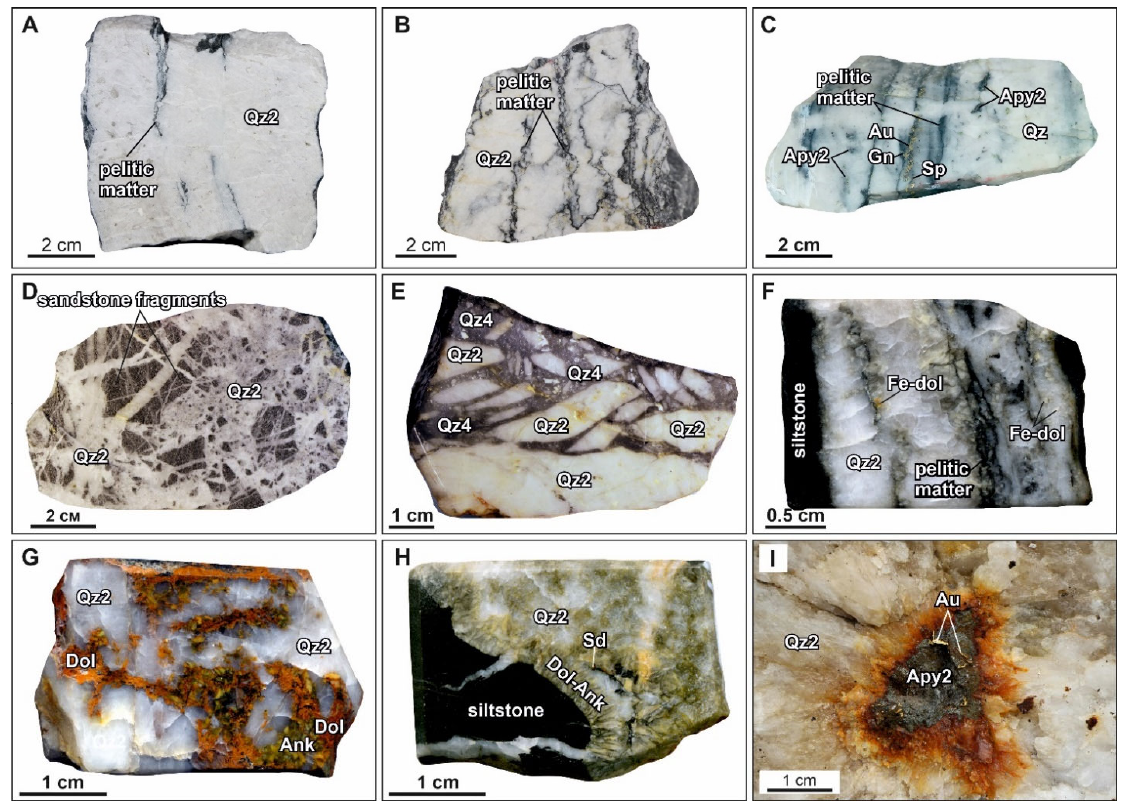
Figure 6. Photographs showing representative mineral assemblages and textures of the vein miner ‐ als in the studied OGDs, central YKMB: ( A ) Milky ‐ white quartz with a massive texture; thread ‐ like interlayers of siltstone composition separate the bands of subhedral quartz from the anhedral quartz; ( B ) banded texture of quartz vein; ( C ) Alternation of banded and massive quartz; ( D ) brec ‐ cia ‐ like texture of quartz vein, milky ‐ white quartz forms overgrowth textures around the rock frag ‐ ments; ( E ) spherulitic and cryptogranular quartz cement vein quartz (Qz1); ( F ) Fe ‐ dolomite forms a rhythmically ‐ banded texture in a quartz vein; ( G ) veinlets and nests of intensely oxidized dolomite– ankerite; ( H ) quartz with siltstone xenoliths overgrown with combed dolomite–ankerite with Mg ‐ siderite inclusions; ( I ) in milky ‐ white quartz, a nest of arsenopyrite with dendrite ‐ like gold in cracks. Abbreviations: Gn—galena, Sp—sphalerite, Apy—arsenopyrite, Dol—dolomite, Ank—ankerite, Sd—siderite.